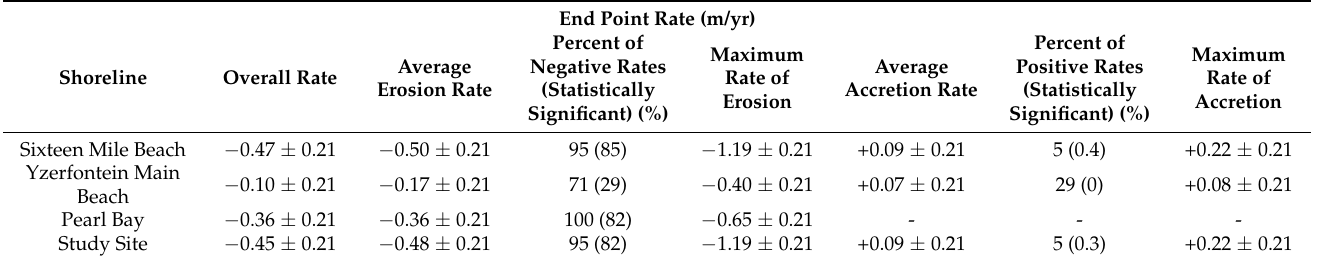
Table 7. Summary of End Point Rates of change (EPR) to the study site shoreline and its three beaches with erosional rates as negative and accretional rates as